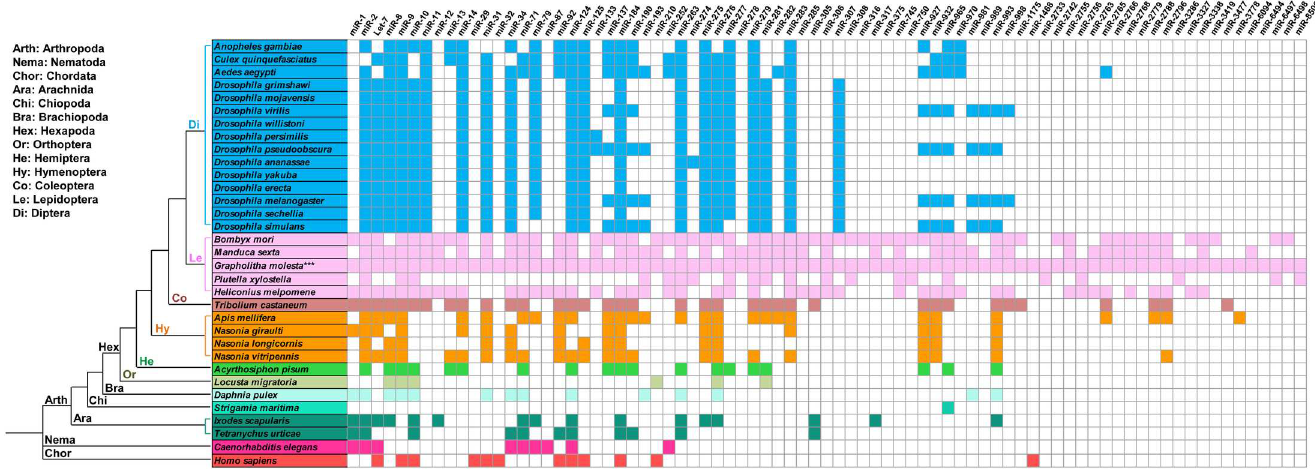
Fig 2. Conservation analysis of 79 miRNA famililes within 33 species. Conservationanalysisof the 79 miRNA families identified from the sRNA library of G . molesta was conductedamong33 species belongingto the three phyla, Arthropoda, Nematoda and Chordata. The miRNA information of the other 32 species was retrieved from the miRBase. Coloredbox indicatedthe presenceof the conservedmiRNA family and the same color indicated species belongingto the same order of insect in Hexapoda, the same class in Arthropoda except for the Hexapodaspecies, C . elegans in Nematoda, and Homo sampiens in Chordata. The phylogenetictree was constructed accordingto previousreports [48,49].